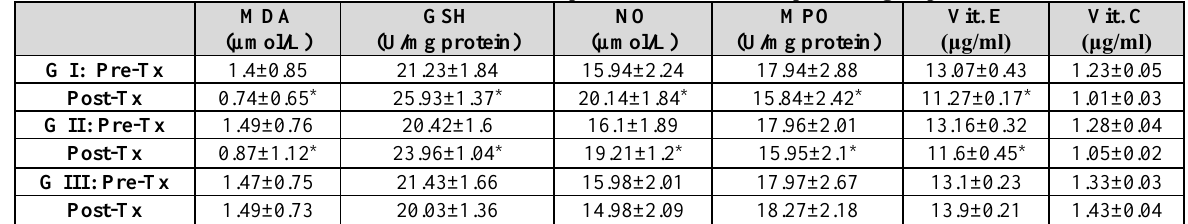
Assessment of Trolox equivalent